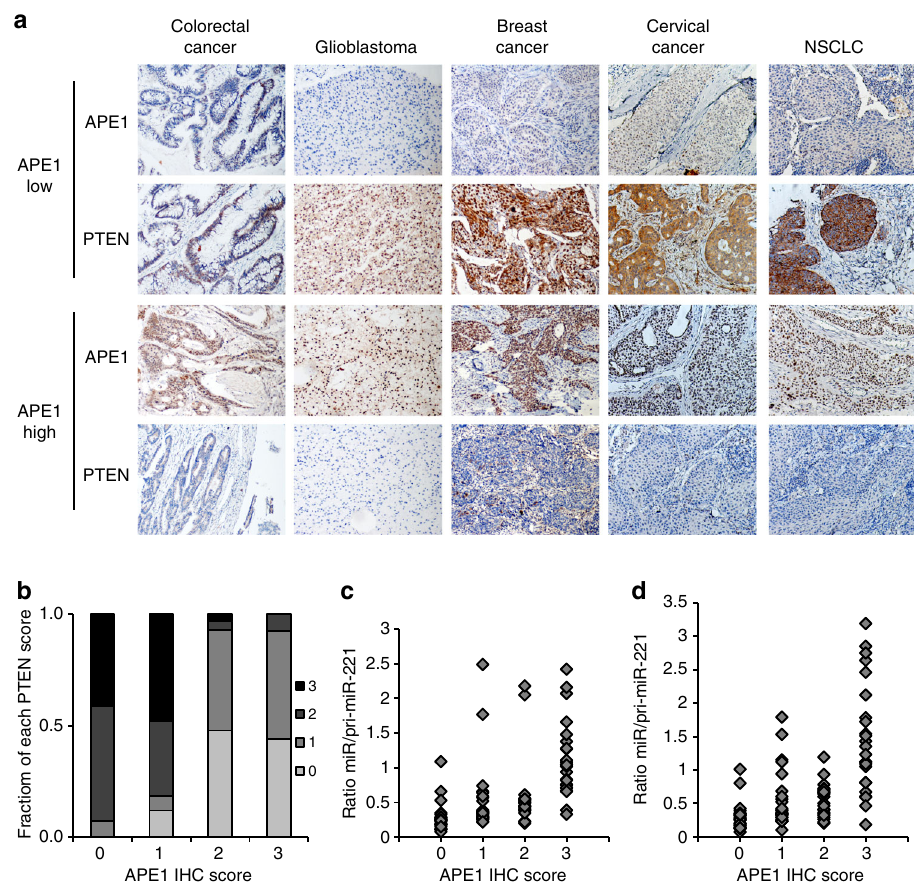
Fig. 6 Correlative expression of APE1 and miR-221/222 with PTEN in a cohort of human cancer specimens. a APE1 and PTEN protein expression were determined by IHC assay and the representative images of both APE1 and PTEN were shown. PTEN expression signi fi cantly increased in tumor tissues showing poor APE1 expression, while was suppressed in tumor tissues showing high APE1 expression. b Bar graph showing the percentage of each score level of PTEN in 0, 1, 2, and 3 score level of APE1. Data were categorized as follow: (i) score 0, no expression in tumor cells; (ii) score 1, faint/barely perceptible partial expression in < 10% of tumor cells; (iii) score 2, weak to moderate expression in > 10% of tumor cells; (iv) score 3, strong expression in > 10% of tumor cells. c and d Scattered plots showing distribution of miR to pri-miR ratios for miR-221 and miR-222 in each score level of APE1 – protein staining,